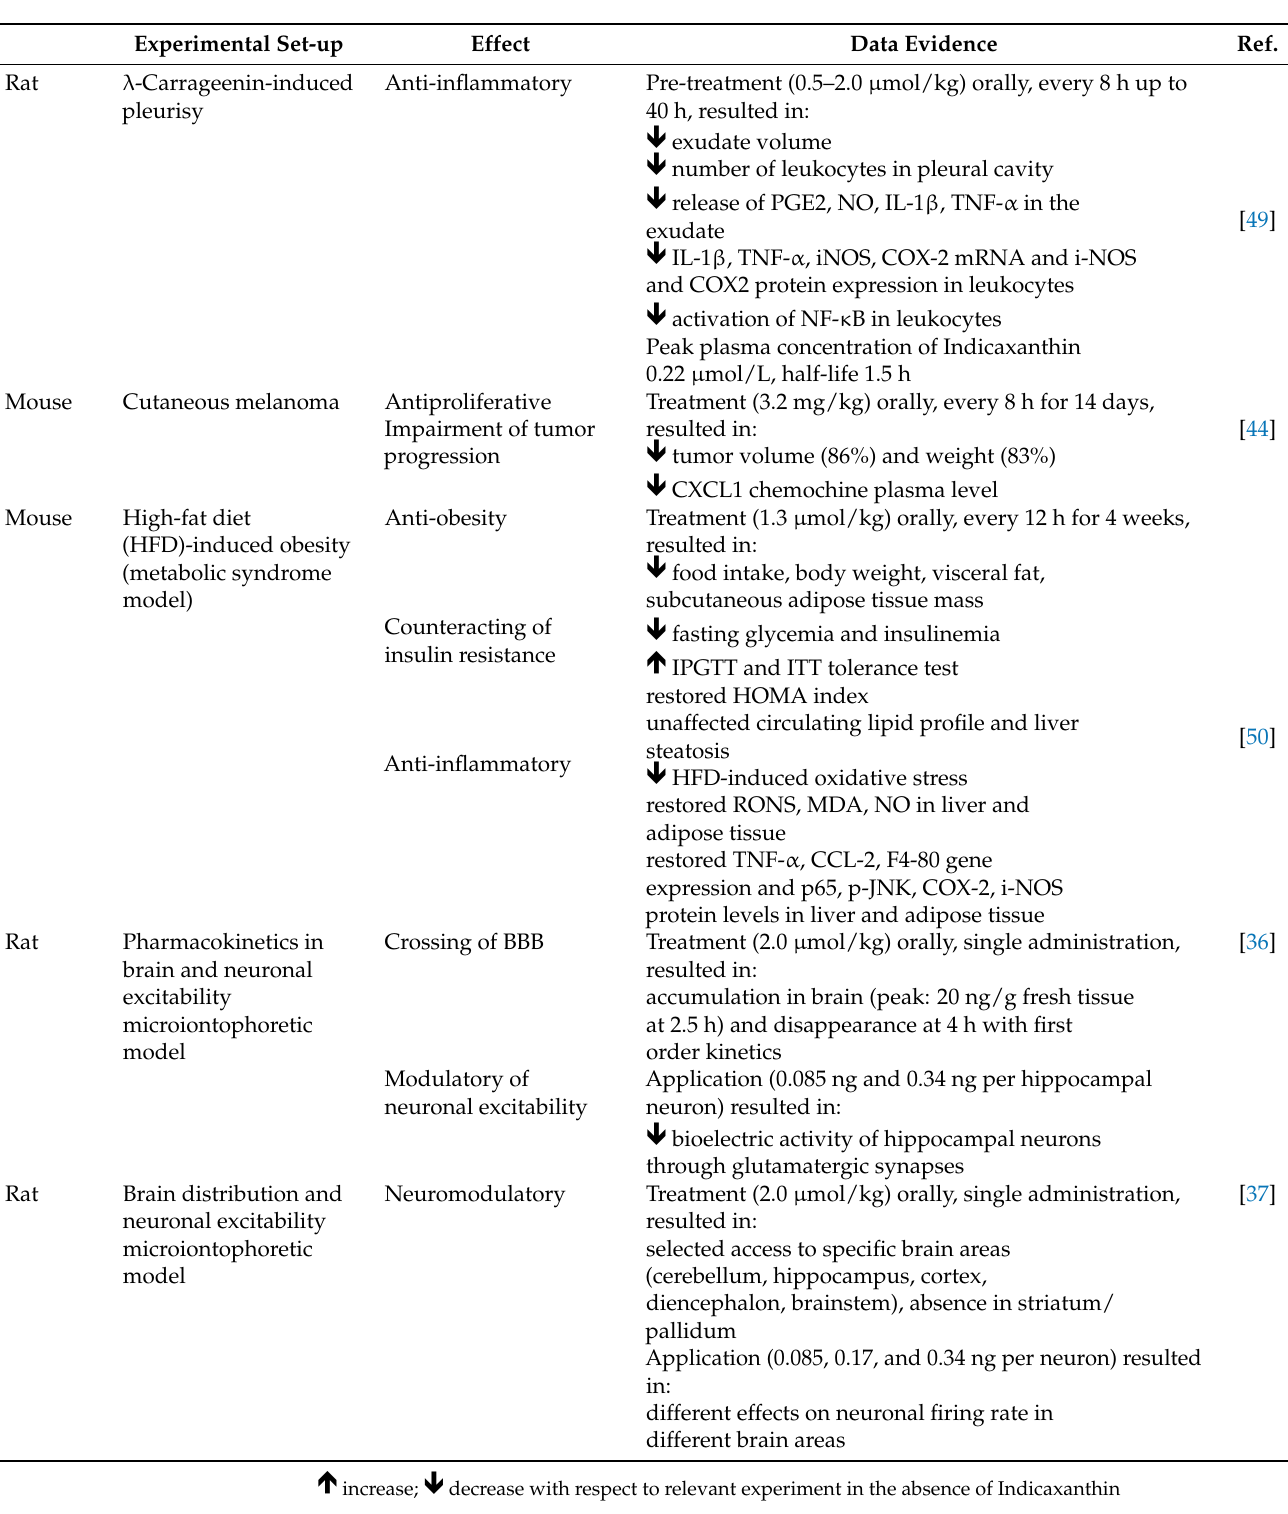
Table 6. Activity of Indicaxanthin in murine models.